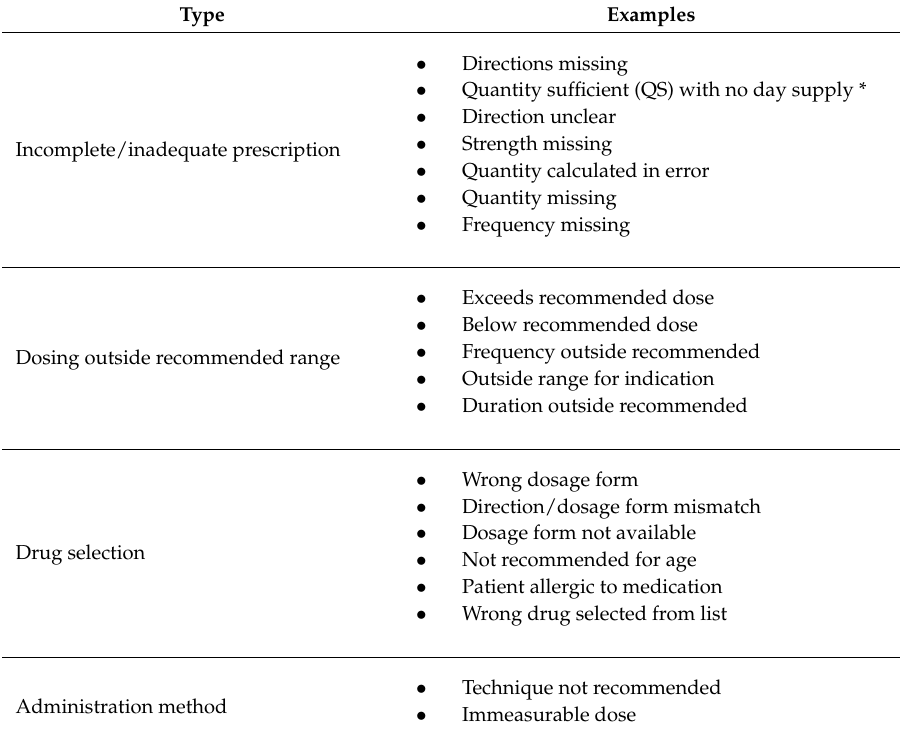
Table 2. Types of medication prescribing errors